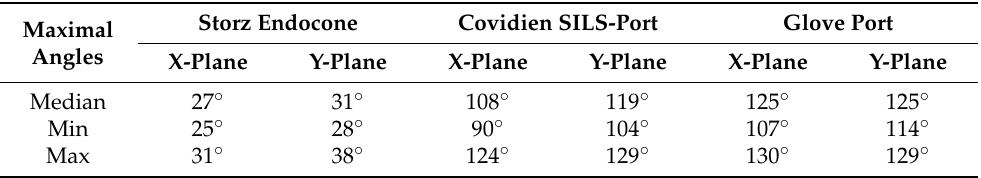
Table 2. Maximal measured angles in the X- and Y-planes within the respective ports when an endoscope (10 mm) and instrument (5 mm) were